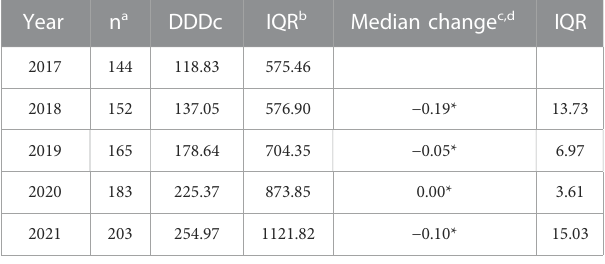
TABLE 2 Change in cost of de fi ned daily dose (DDDc) nationwide of orphan drugs in China (RMB).